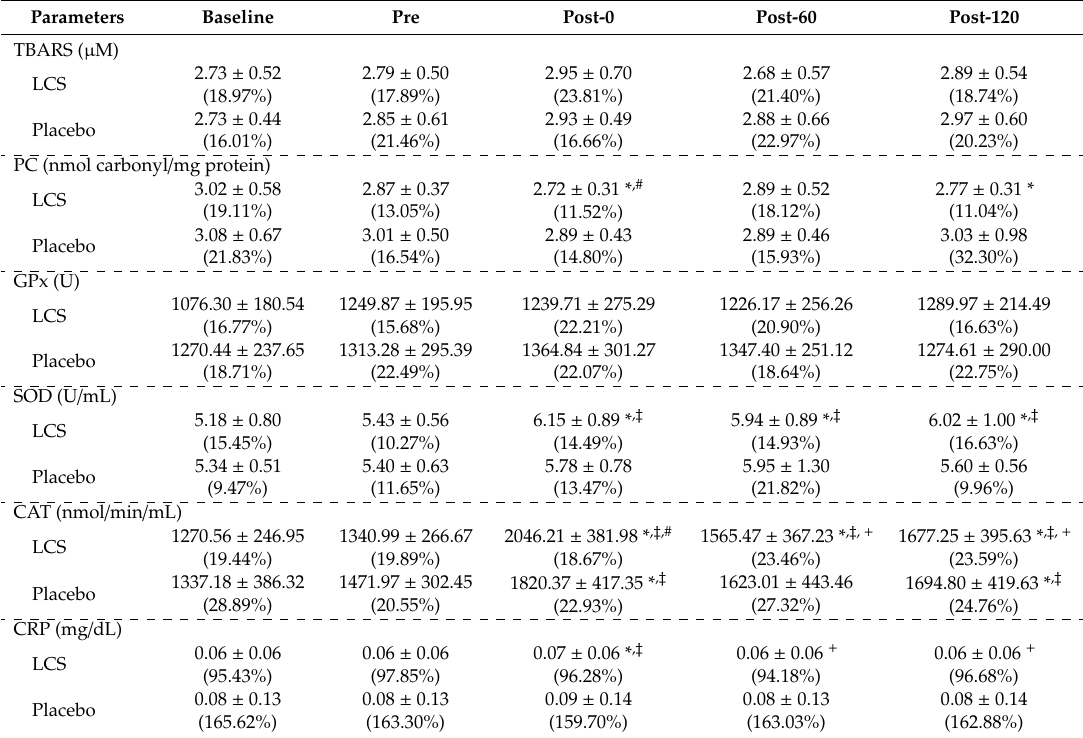
Table 3. Changes in oxidative stress, antioxidative capacity, and inflammation after exhaustive endurance exercise.